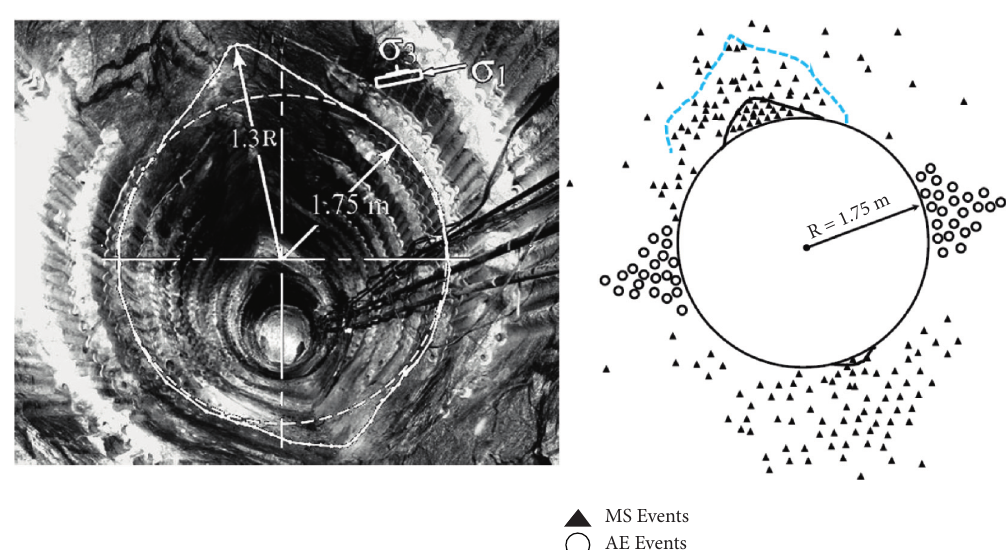
Figure 1: On-site monitoring results of the URL test tunnel [23].